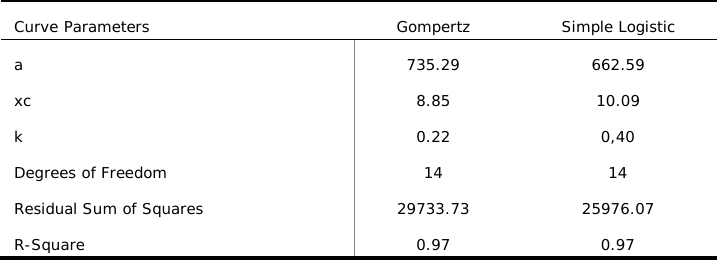
Table 3. Updated parameters obtained for each model